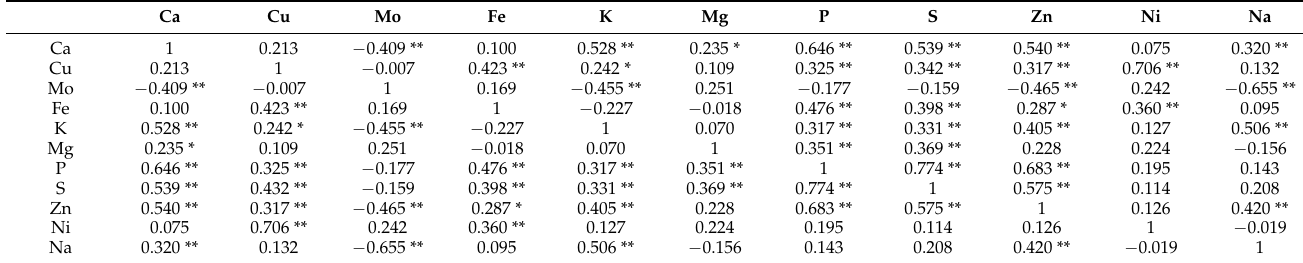
Table 2. Pearson correlation coefficient values between element content in winter oat whole grains (Debrecen,